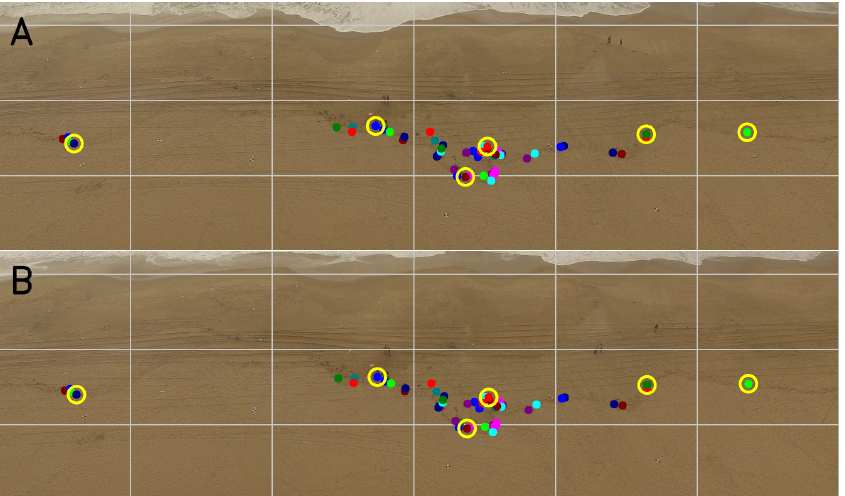
Figure 4. Feature matches for an image from the video ( A ) and an image from the basis ( B ) (the images appear cropped for convenience). The matches are plotted with the same color in both images. The 6 × 6 grid is included and the best pair of each cell is highlighted with a yellow